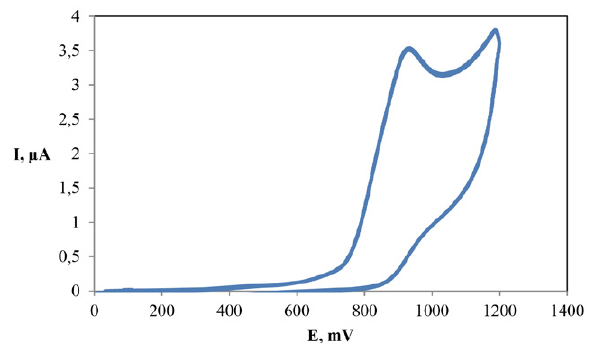
Figure 2. The results are the average of five separate determinations Cyclic voltammogram of 0.1 mM SLC in BR buffer of pH 7.0 at a bare carbon paste lectrode.